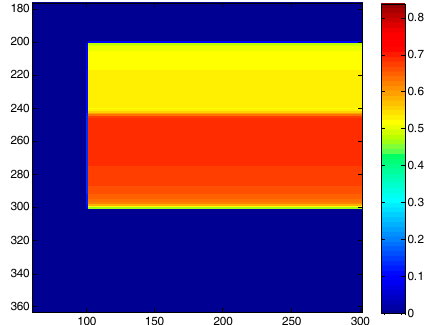
Figure 11. Sharp shock profile on a simulated propeller blade (to be recovered). Colors represent the intensity captured in the Gate 2 image, and axes represent pixels of the image in Cartesian coordinates.